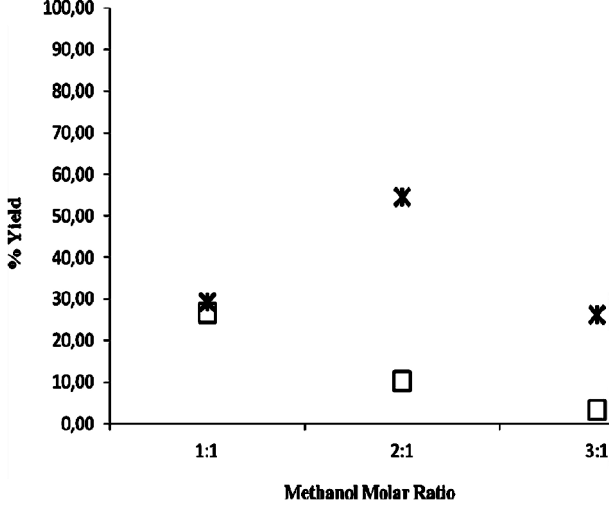
Figure 4. Effect of methanol concentration on CaL-S (star) and CaL-M (square) expressed as the conversion in methyl ester achieved after 25 h. The transesterification of triolein was carried out at 30 °C with molar ratios of 1:1, 2:1 and 3:1. Therefore, theoretical maximum conversions achievable were 33%, 66% and 100%, respectively.